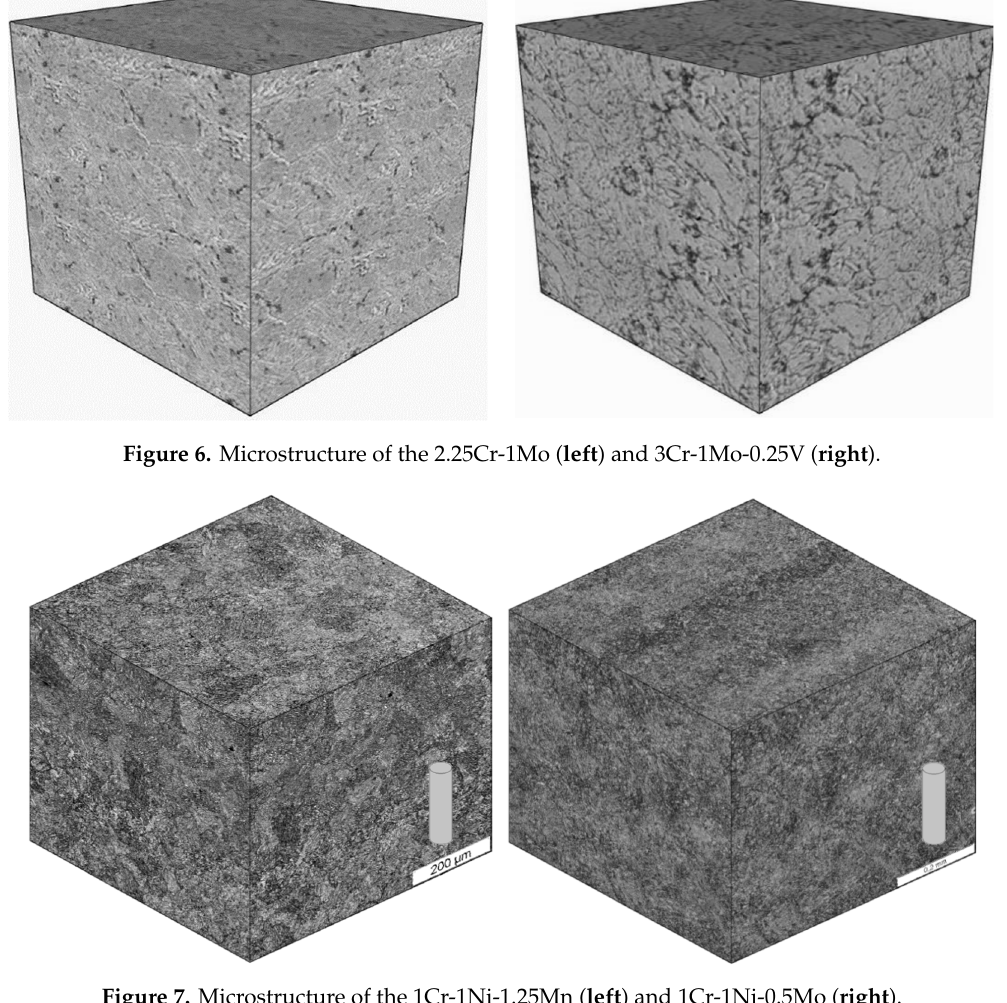
Figure 7. Microstructure of the 1Cr-1Ni-1.25Mn ( left ) and 1Cr-1Ni-0.5Mo ( right ).